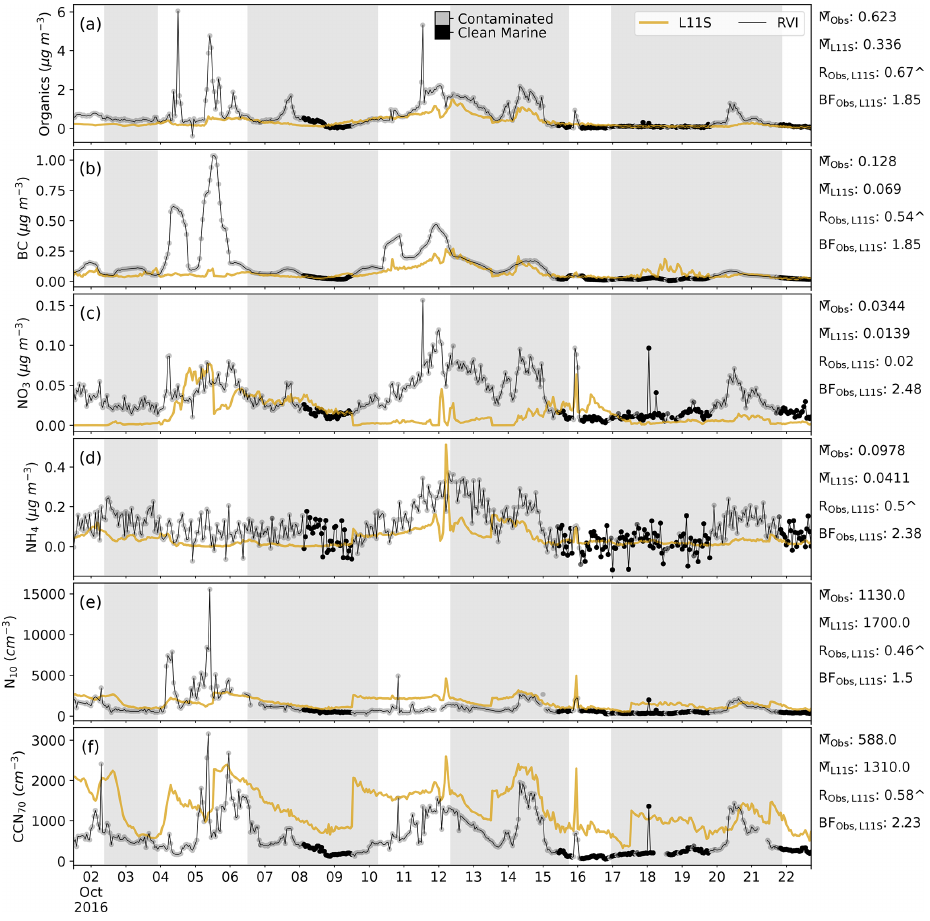
Figure C3. Time series along the RVI track in descending order of surface organic, BC, NO 3 and NH 4 aerosol mass, aerosol number greater than 10nm ( N 10 ) and cloud condensation nuclei greater than 70µm (CCN 70 ), comparing the L11S simulation (yellow) to the observations (black). Summary statistics are shown for the observations and L11S including the mean ( M ), the Pearson correlation ( R ) and the normalised mean bias factor. ∧ indicates where the R values are significant to the 95th percentile. The shaded grey areas in (a) – (f) represent periods when the ship was at a station. Observations in the time series are flagged by grey dots when the air mass was considered to be influenced by exhaust, terrestrial air mass or both (contaminated), including a log flag. Flagged values have been excluded from the